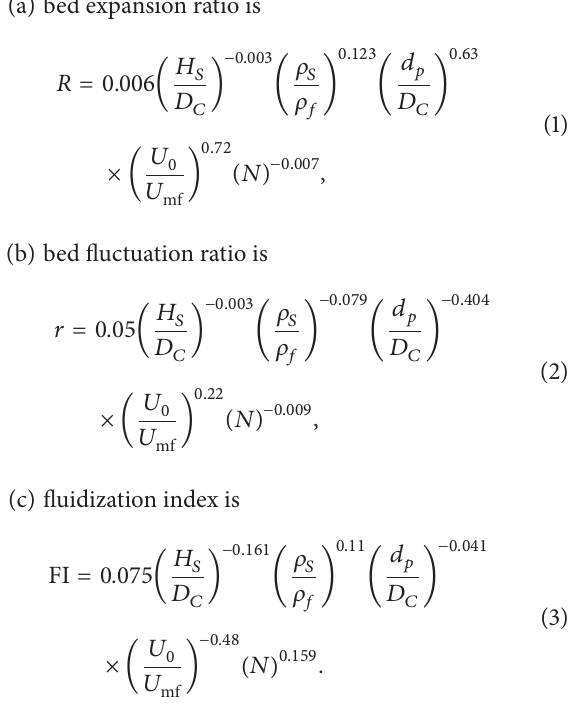
for the fluidizing process due to single number of orifice in distributor for the former case.